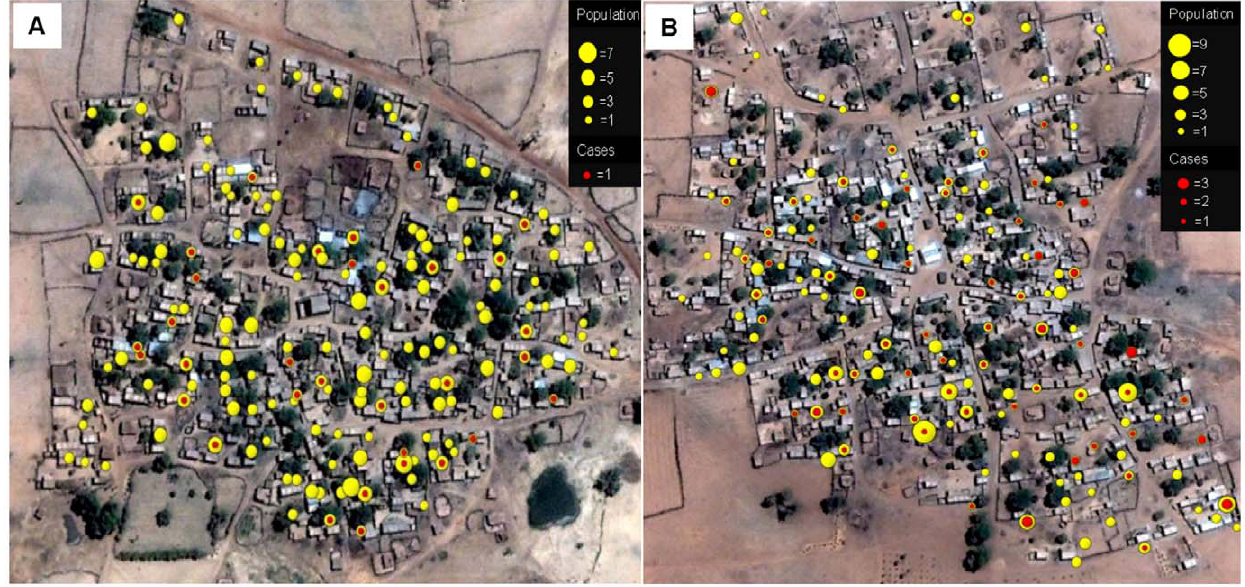
Figure 4. Spatial distribution of LST-positive individuals. Combined distribution of LST-positive individuals (red circles) during 2007 and 2008 relative to number of inhabitants per household (yellow circles) in the village of Kemena (A) and Sougoula (B). Diameters of yellow and red circles are proportional to the number of individuals in each location.